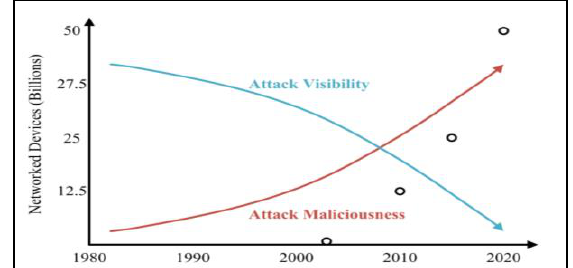
Figure 1. Growth of Networked Devices and Cyber-Attack Visibility and Maliciousness Trends, adopted from Wells et al., (2014)